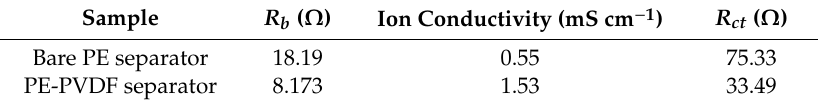
Figure 6. ( a ) Ionic conductivities of the liquid electrolyte-soaking separators; ( b ) Nyquist plots of cells containing bare PE and PE-PVDF separators after pre-cycling at 0.1 C. Table 4. Ionic conductivities and impedances of bare PE and PE-PVDF separators.